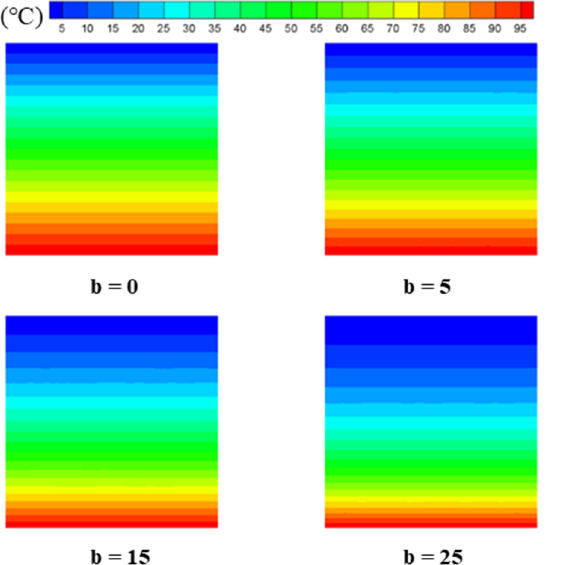
Figure 11. Temperature distribution of the plate with exponential distribution for steady-state heat conduction.